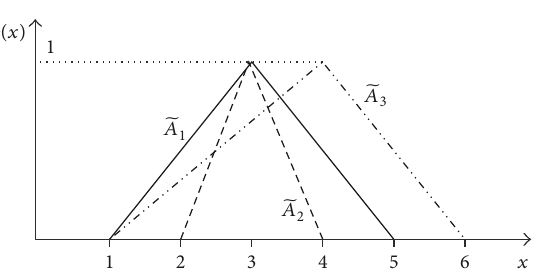
̃𝐴 ̃𝐴 ̃𝐴 1 , 2 , and 3 in Example